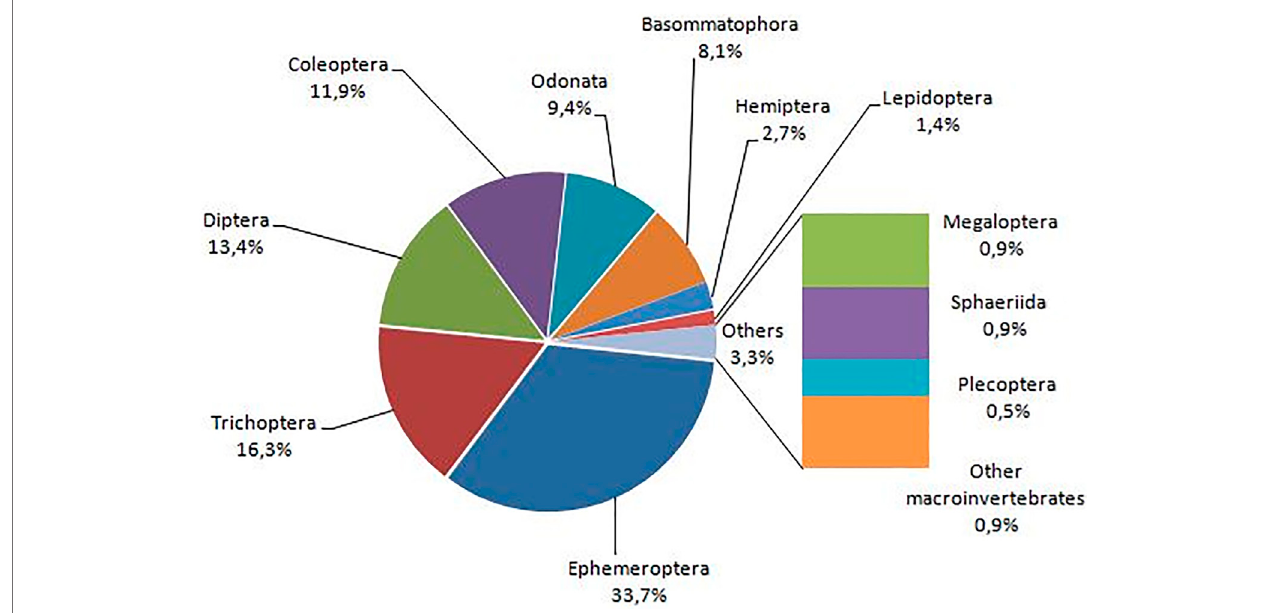
FIGURE 5 | Pie-graph is indicating the abundance percentage per order of the total study sample.